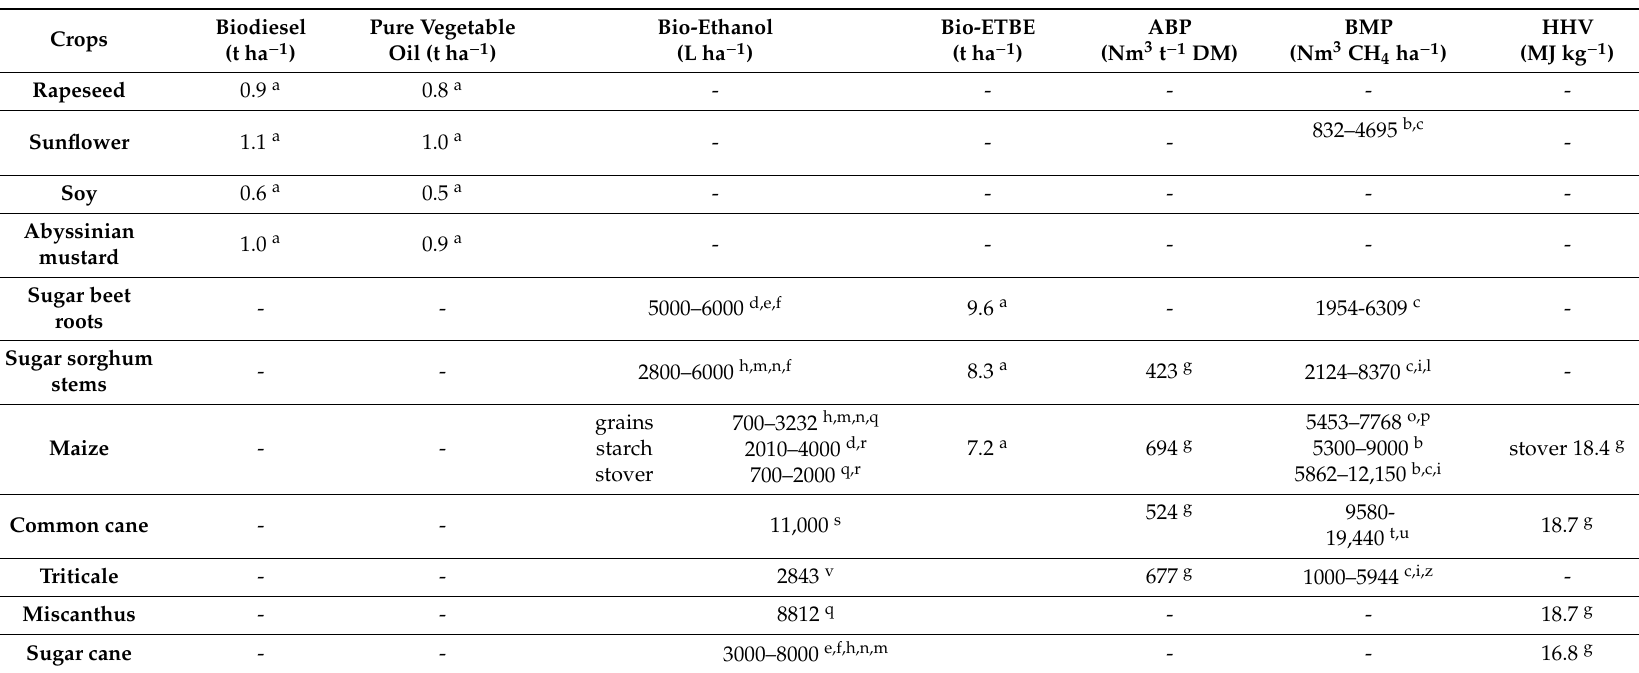
Table 4. Average yields of biodiesel, pure vegetable oil, bioethanol, and bio-ETBE, and the lower anaerobic biogasification potential (ABP), biomethane production (BMP), and higher heating value (HHV) of the principal energy